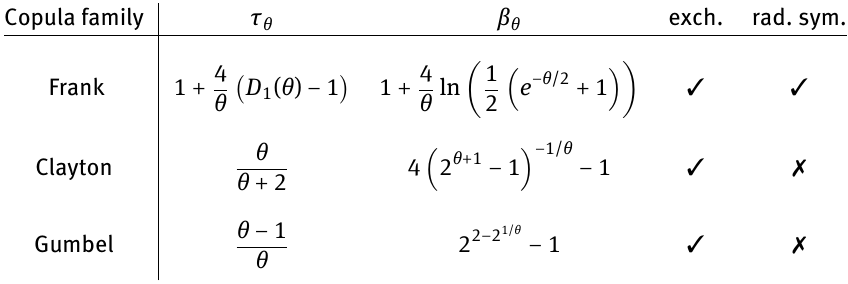
(cid:82) x t k dt . 0 e t −1 x k exch. rad. β θ